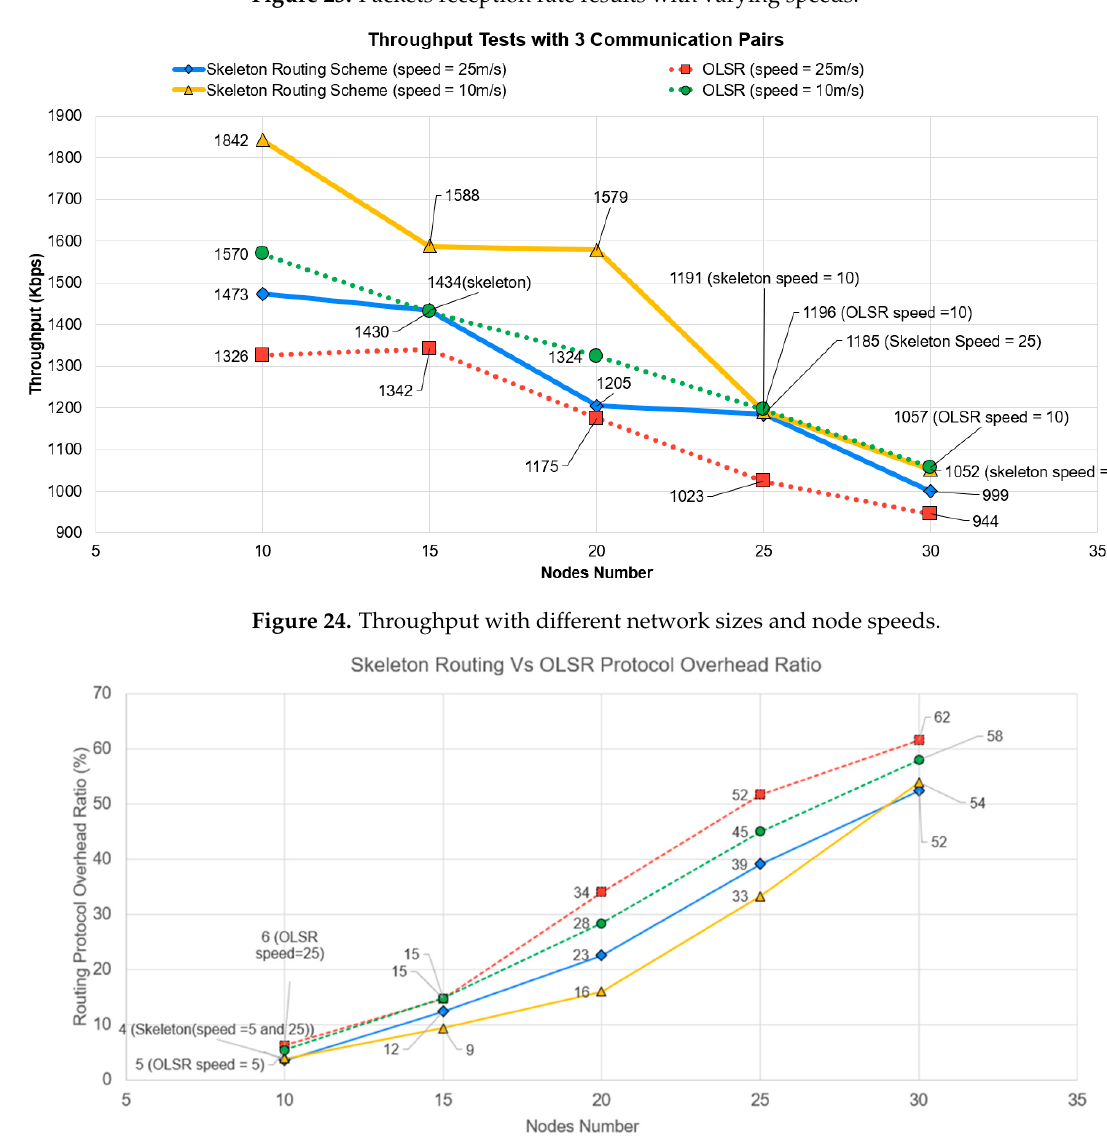
Figure 23. Packets reception rate results with varying speeds.